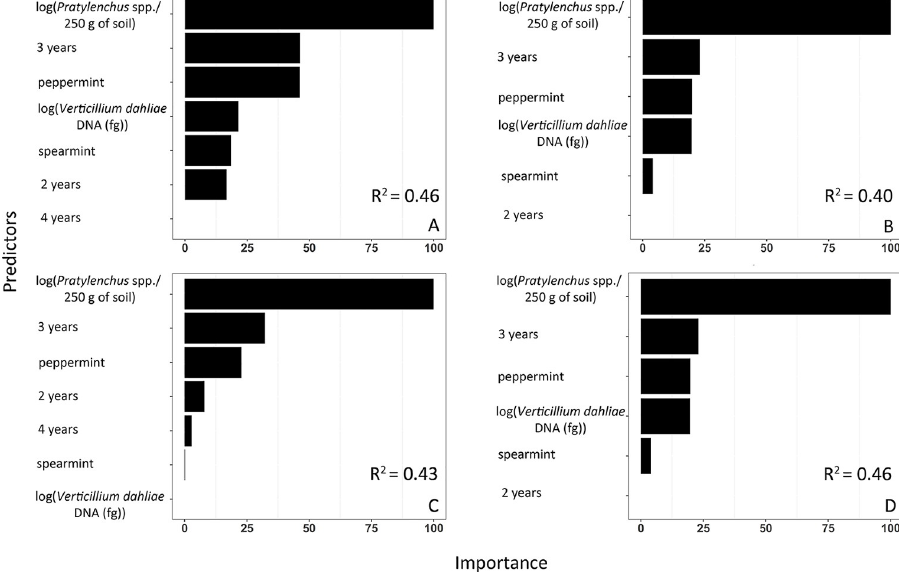
Fig 5. Contribution of each predictor to wilt. Importance of Verticillium wilt predictors and explanatory performance, expressed as coefficients of determination (R 2 ), of (A) the multiple linear regression model, (B) generalized additive model, (C) random forest, (D) and artificial neural